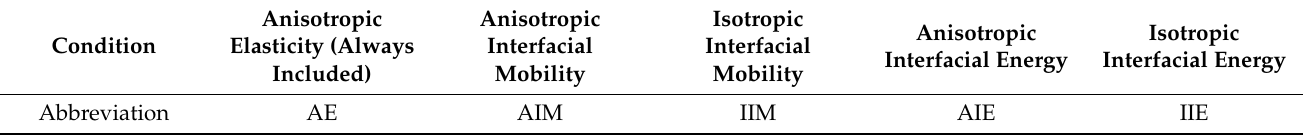
Table 4. Isotropy conditions of the simulations